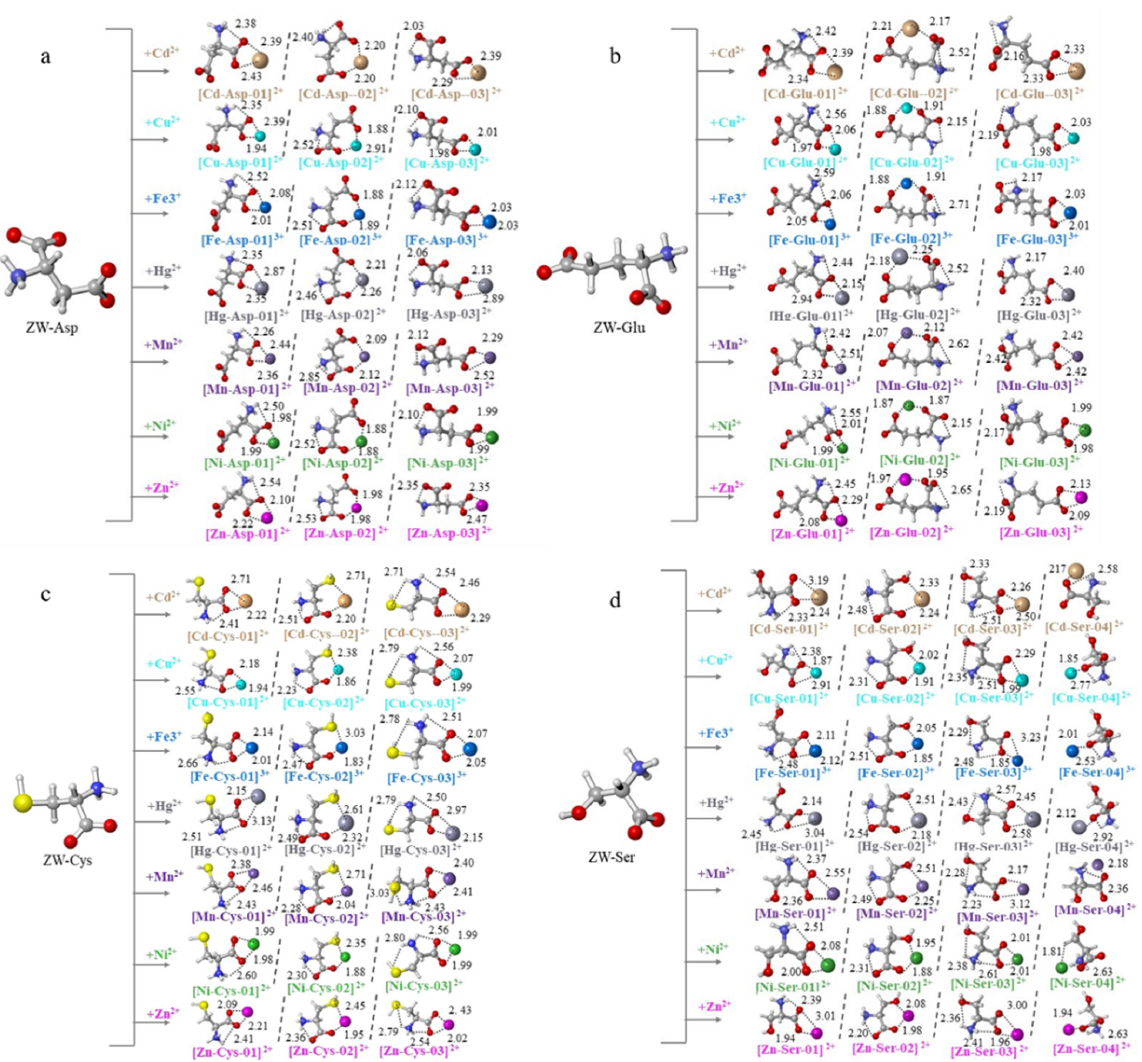
Figure 2. The optimized structures of [acidic/sulfhydryl/hydroxy AA-metal cation] complexes. AA = Asp ( a ), Glu ( b ), Cys ( c ), Ser ( d ); the numbers in the figure indicated the hydrogen bond length in a complex molecule, and the distance between the metal cation and the interacting atom; the length in Å.